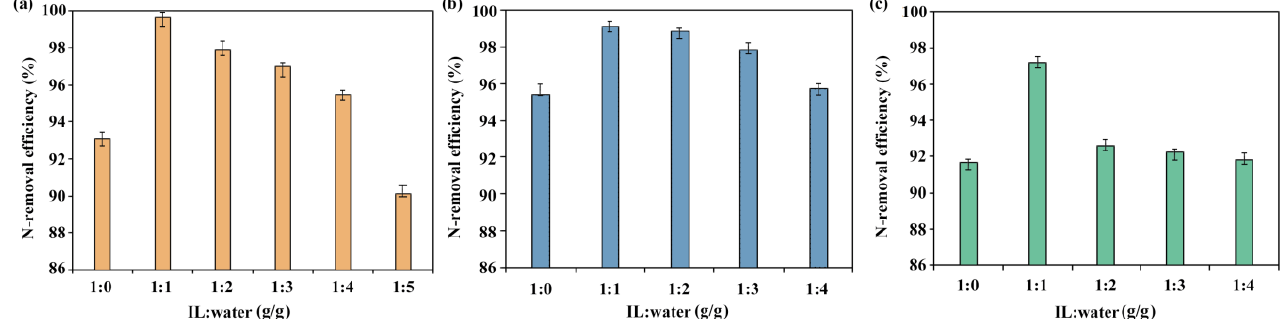
Figure 4. N-removal efficiency of the best IL with different mass ratio to water for ( a ) pyridine, ( b ) quinoline, and ( c ) aniline.